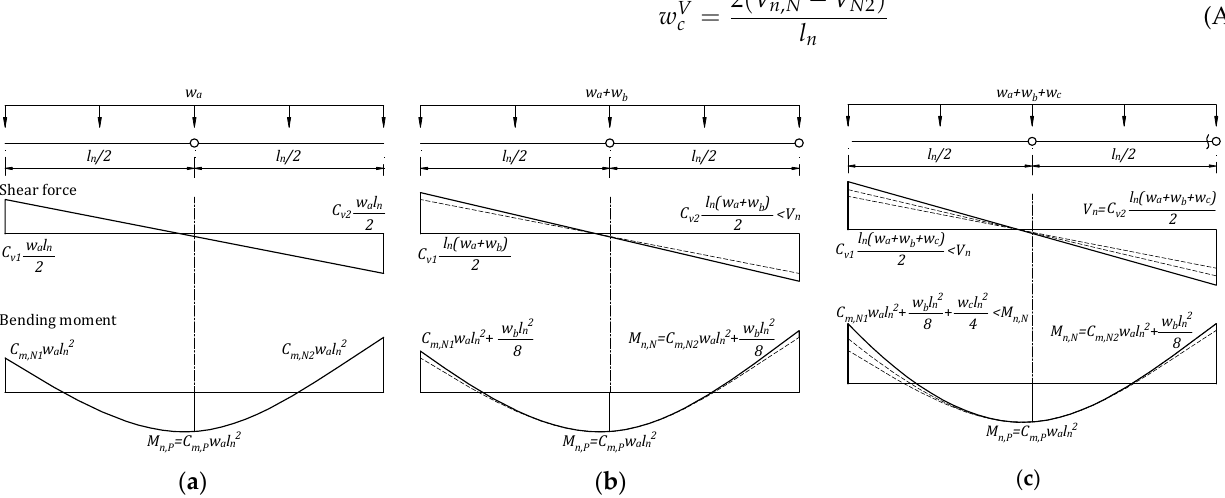
Figure A7. The failure mechanism for DB-3b region. ( a ) Flexural failure at the mid-span section first; next, ( b ) flexural failure at the N2 section; and finally, ( c ) shear failure at the N2 section.